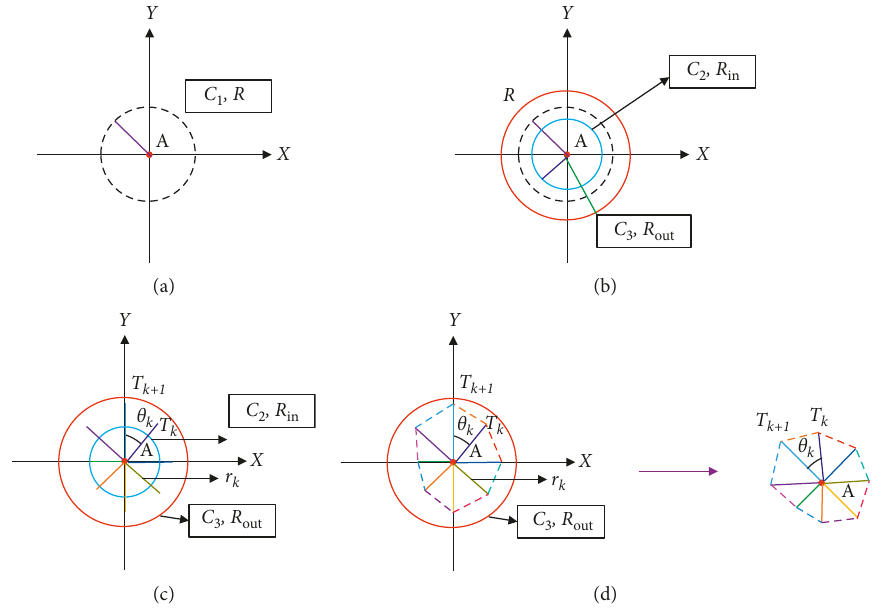
Figure 7: Irregular polygon generation algorithm process of calcite crystals in the MCS samples [13]. (a) Generate the initial cell; (b) generate the characteristic circle; (c) determine the vertex of irregular polygon; (d) irregular polygon